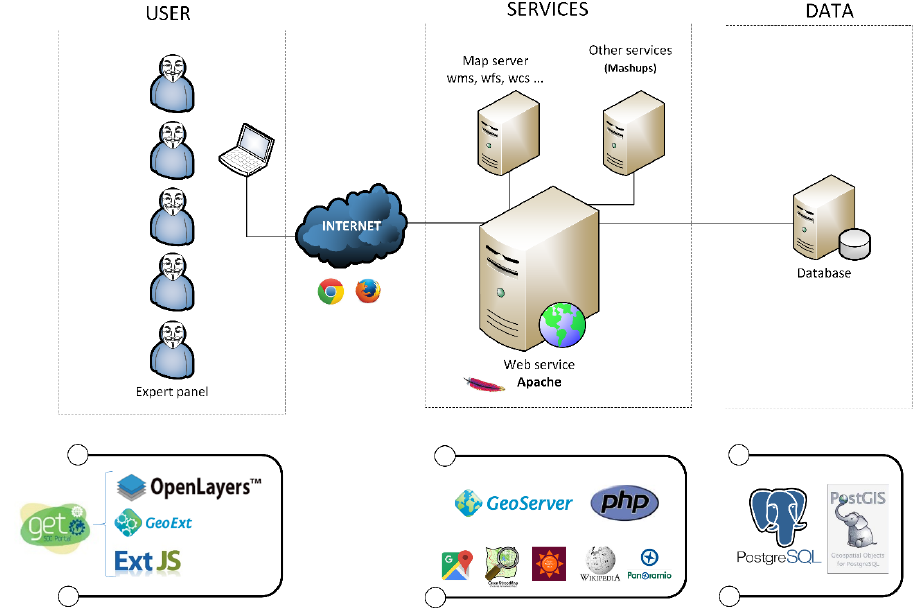
Figure 1. Architecture of Geospatial System of Collective Intelligence (SIGIC).